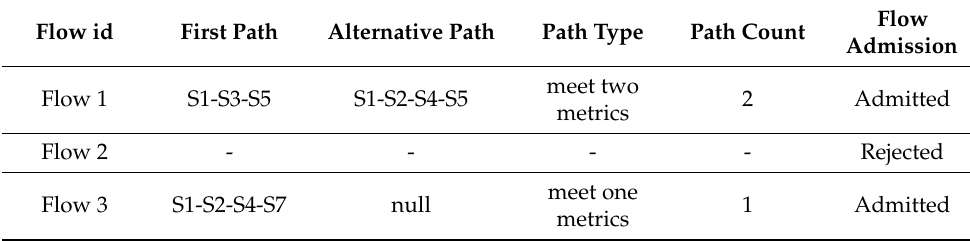
Table 2. Example of the flow path cache and